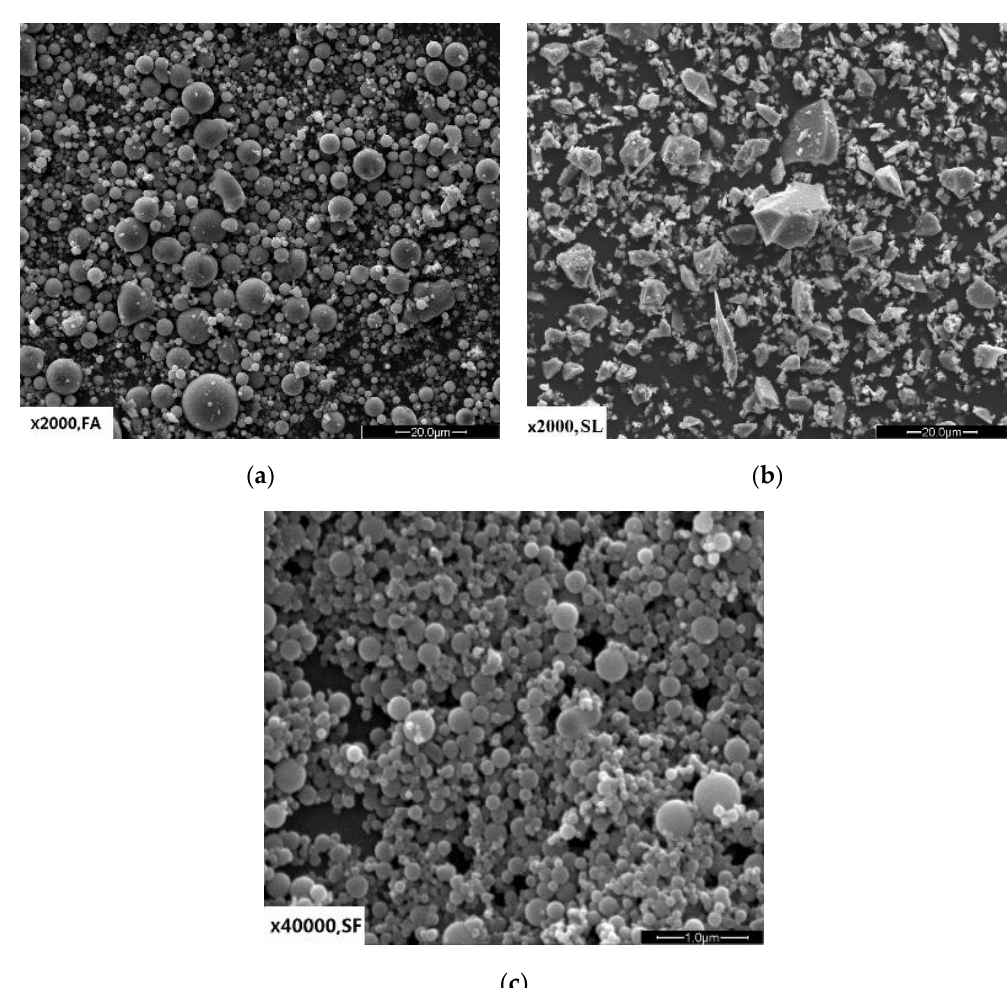
Figure 1. Morphology images of supplementary cementitious materials, ( a ) fly ash, ( b ) slag, and ( c ) silica fume.